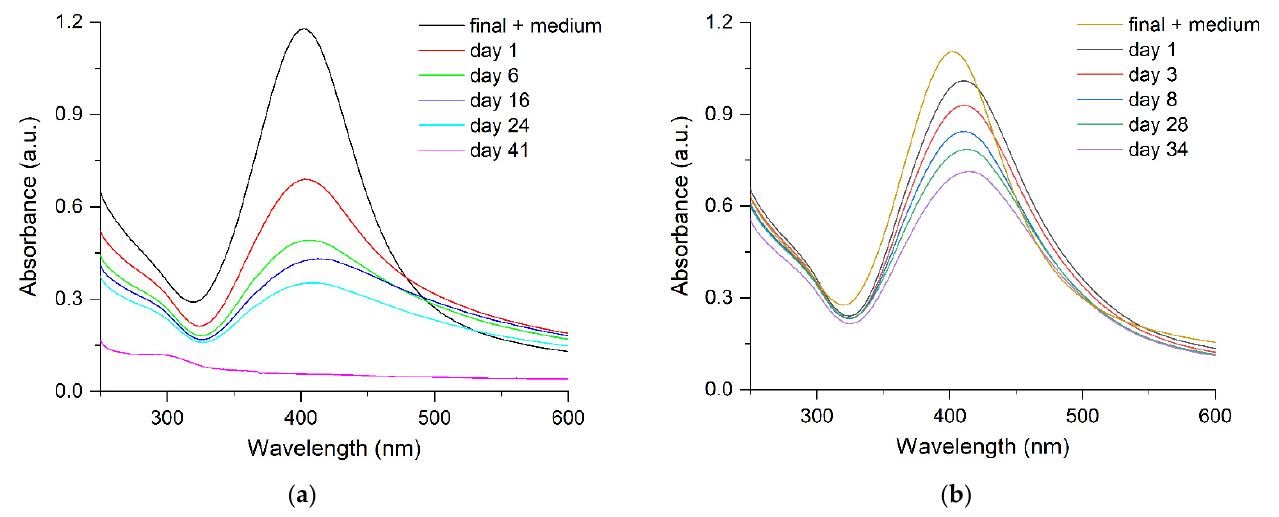
Figure 4. Absorption spectra of silver hydrosol ( a ) Ag-NPs and ( b ) Ag-Ag 2 O-NPs in modified liquid culture medium “Adkins M”.